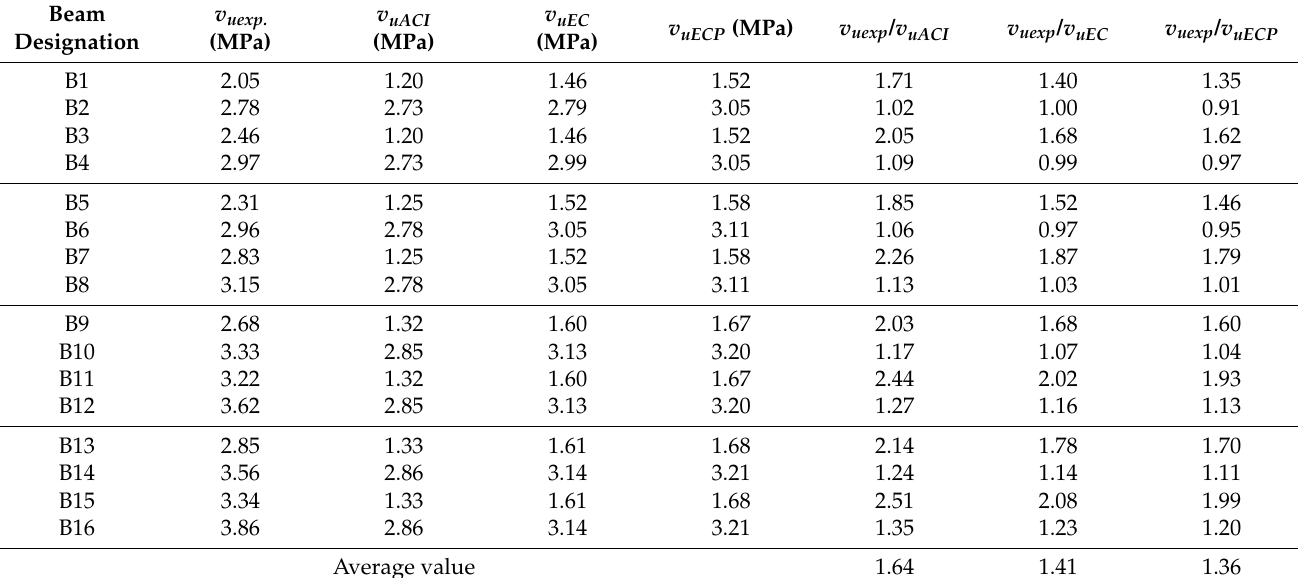
Table 6. Comparison of experimental test results with analyzed codes’ design